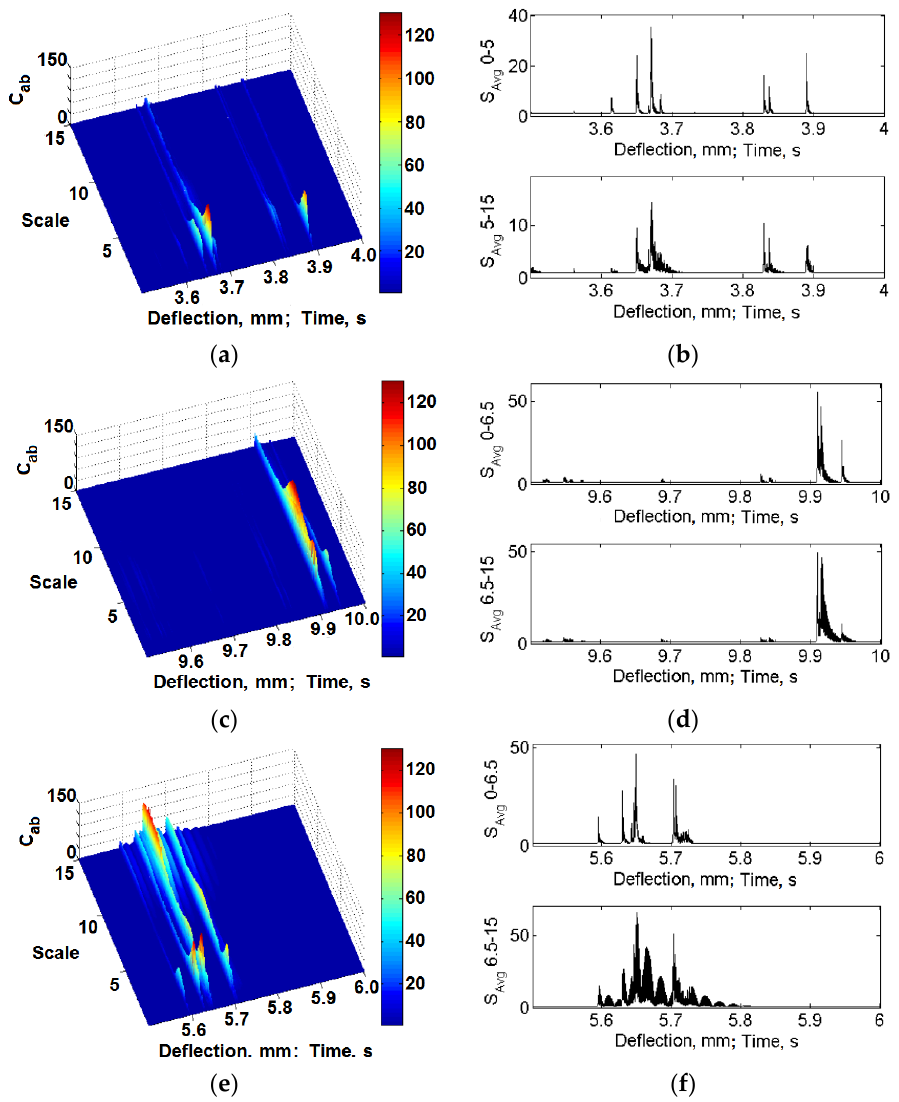
Figure 16. Exemplary time frequency scale distributions and averaged values, deflection range at which significant laminate degradation damage occurs: ( a – b ) Classic laminate; ( c – d ) 3D ‐ W laminate; ( e – f ) 3D ‐ P laminate.